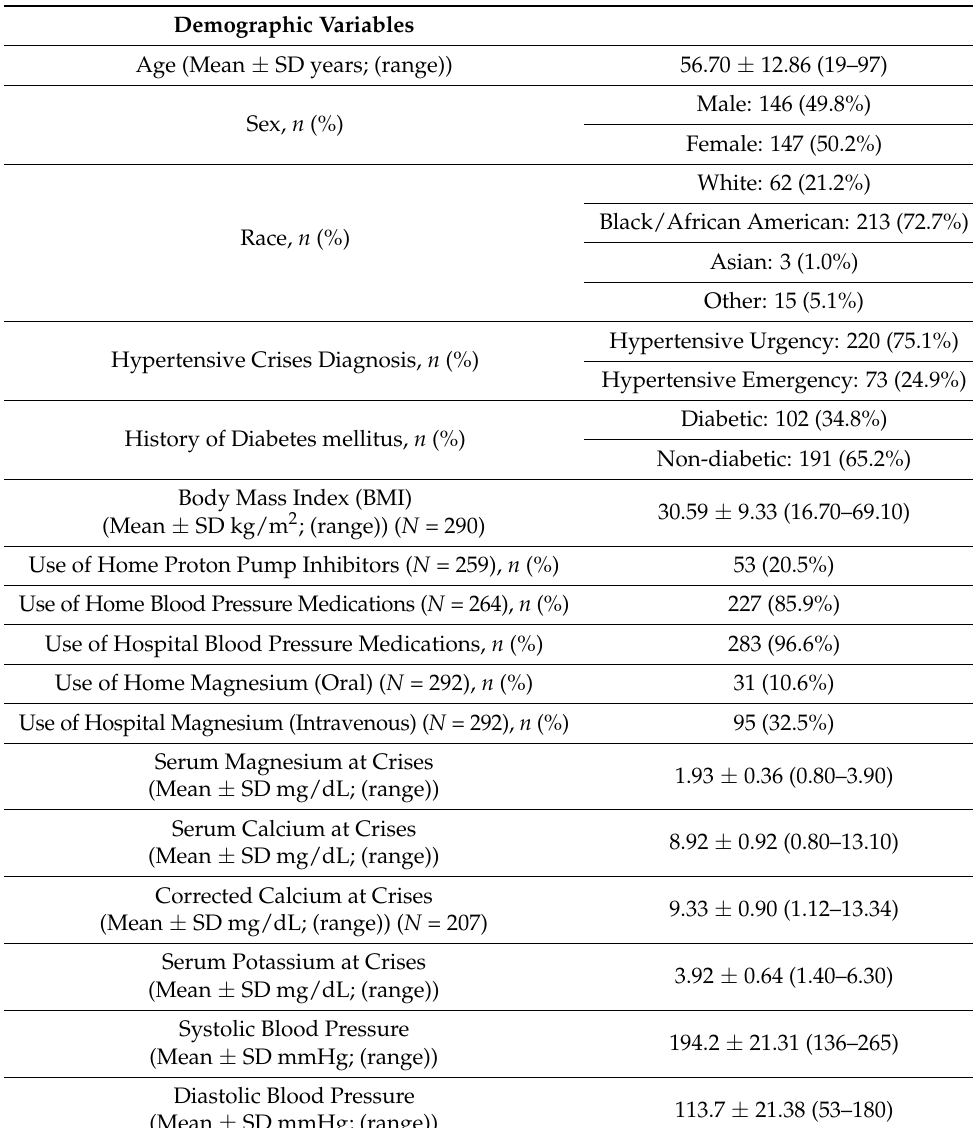
Table 1. Baseline characteristics ( N =